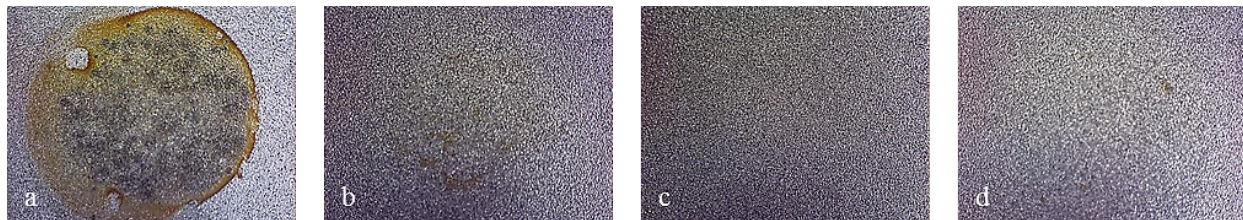
Figure 15. Working area after polarization on X2NiCoMo18-8-5 steel, sandblasted finish. ( a ) Bare; ( b ) Monolayer; ( c ) Multilayer 4; ( d ) Multilayer 8.